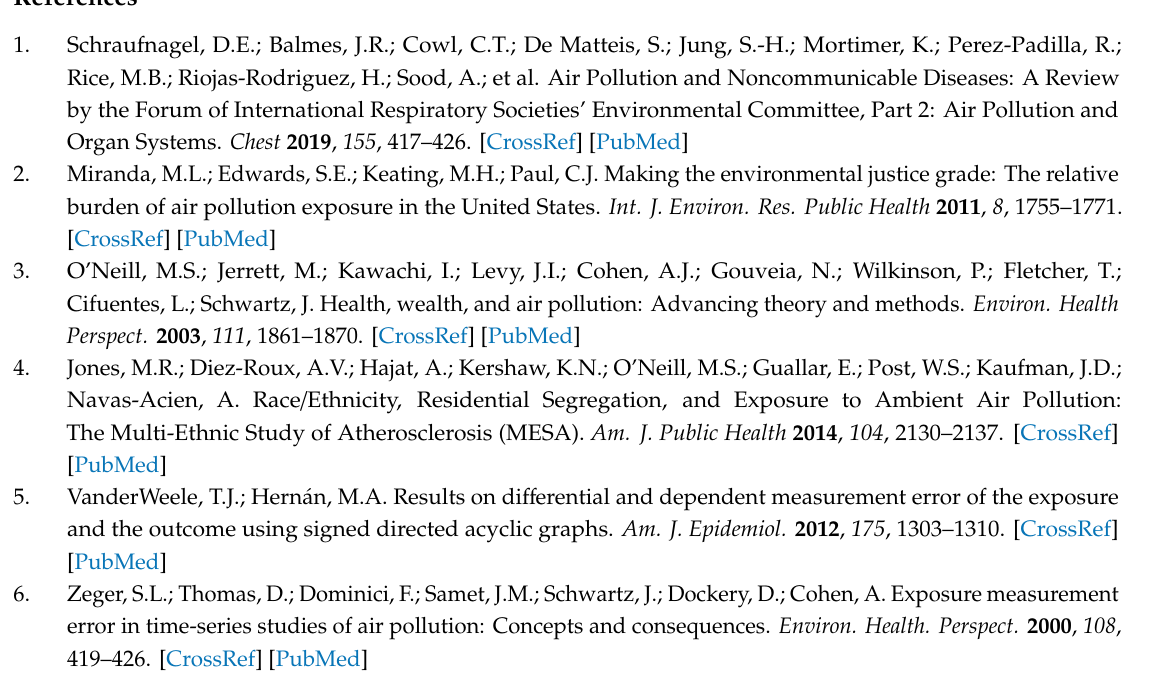
Table S9. OLS and SAR regression models testing bivariate measures of association between CVD and pollutant or social stressor across UHF-34 neighborhoods. Moran’s I to assess autocorrelation in model residuals. Table S10. Fully-adjusted models for each NO 2 -social factor combination vs. census tract CVD and ischemic heart disease (IHD) rate, adjusted for SDI, Violent Crime Rate, and % non-Hispanic black (except where each is main social factor of interest in